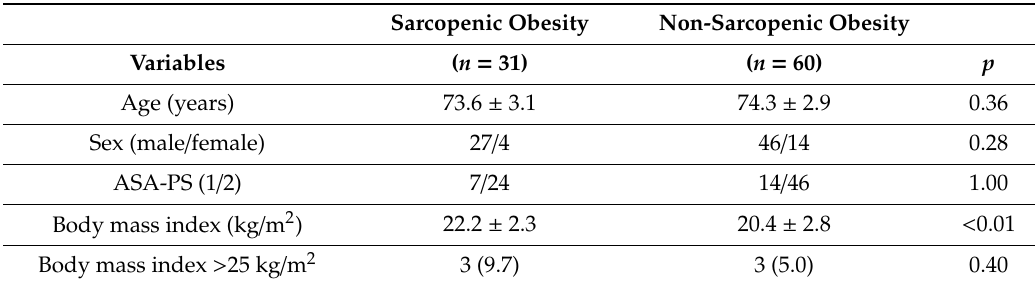
Table 4. Characteristics of nutrition-related factors in elderly patients with or without sarcopenic obesity at